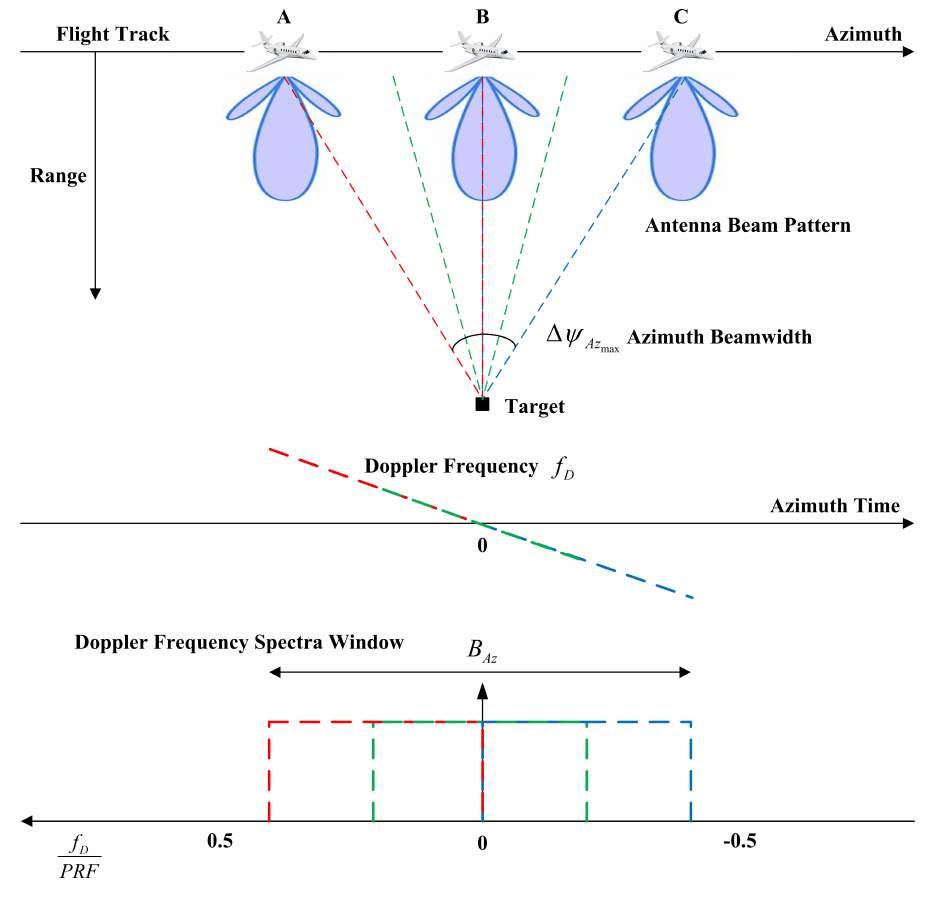
Figure 1. The schematic representation of the synthetic aperture ( top ), Doppler history ( center ), and Doppler spectra ( bottom ) during the synthetic aperture